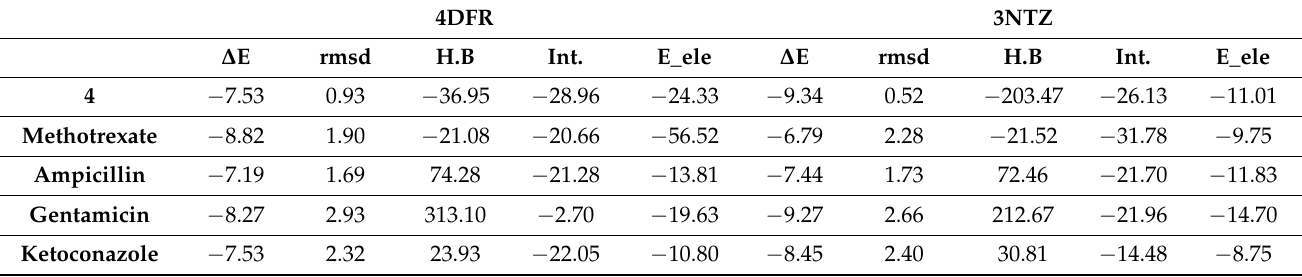
Table 5. The binding-affinity for tested compounds 4 with docking score (kcal/mol) against hDHFR. 4DFR